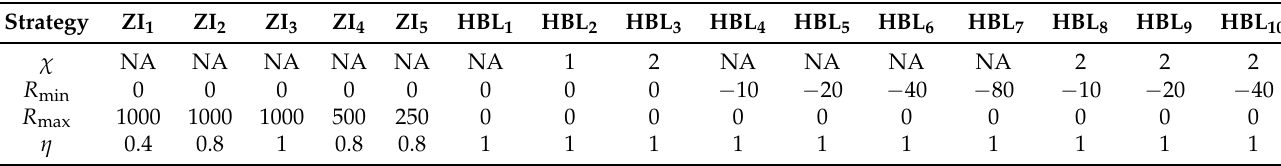
Table A16. Background trading strategies used in EGTA for HBL variations. HBL n − L in tables below means HBL n with memory length of L .